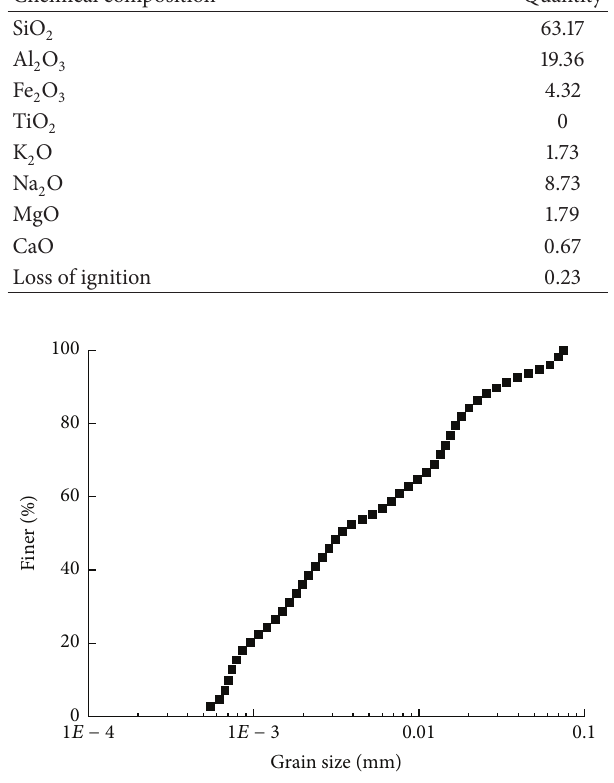
Figure 1: Grain size distributions of tested